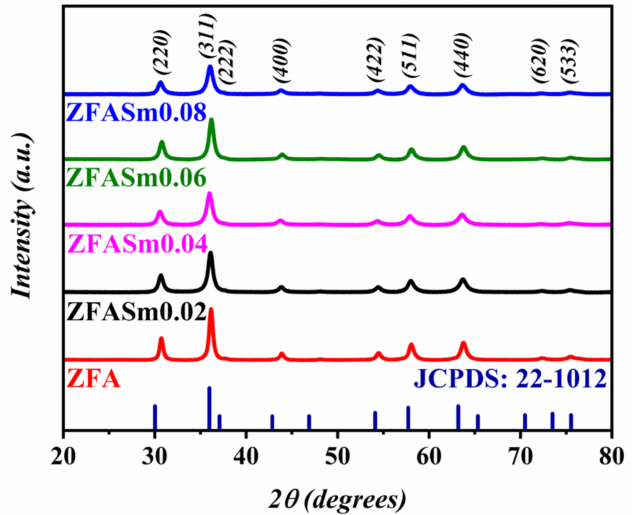
Figure 1. XRD patterns of ZnAlFe 1 − x Sm x O 4 (x = 0, 0.02, 0.04, 0.06, 0.08) photocatalysts compared to the standard XRD pattern of ZnFe 2 O 4 (JCPDS card No.